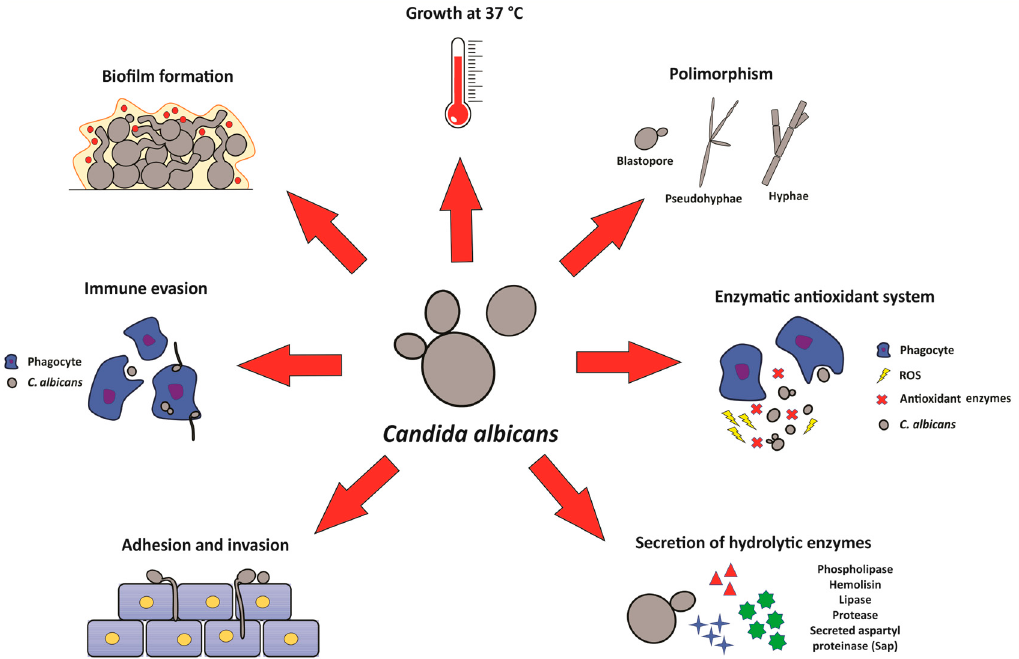
Figure 1. Major virulence factors of C. albicans. C. albicans is a fungal pathogen that is able to grow at 37 °C, transition from the yeast stage to hyphae or pseudohyphae (polymorphism), form biofilms on biotic and abiotic surfaces, evade the immune system by filamentation, adhere and invade tissues and surfaces, secrete several hydrolytic enzymes (phospholipase, haemolysin, lipase, protease, and mainly secreted aspartyl protease—Sap), and enzymes of the fungal antioxidant system (catalase, superoxide dismutase, glutathione peroxidase, and glutathione reductase). ROS: reactive oxygen species.